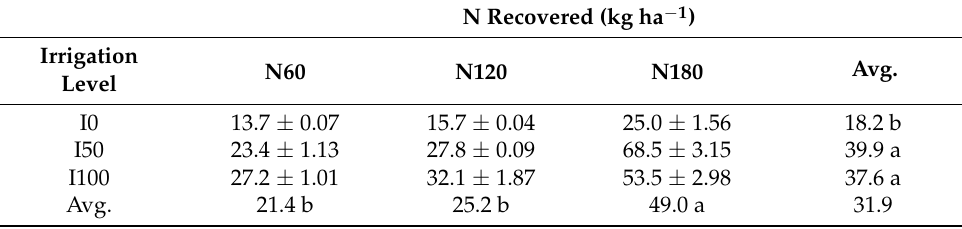
Table 1. N recovered by the crop (kg ha − 1 ) from the fertilizer, in relation to irrigation (I0, I50, I00 = 0, 50, 100% ETc, respectively) and N level (N60, N120, N180 = 60, 120, 180 kg ha − 1 N). Average values of all N levels (last column) and average values of all irrigation levels (last row) followed by the same letter do not significantly differ at p ≤ 0.05. The I × N interaction was not significant. Values of the standard error are